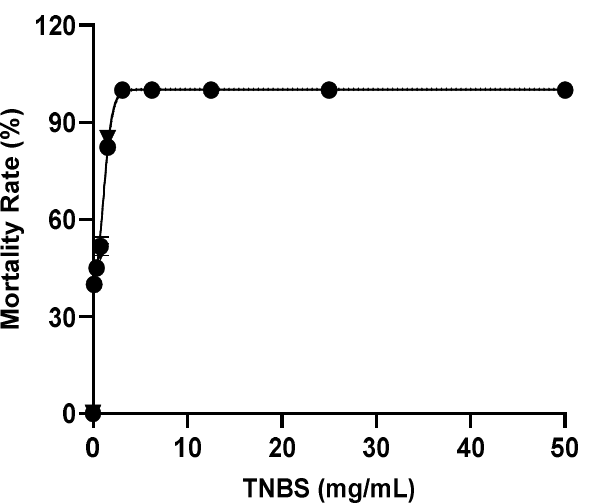
Figure 6. Effect of TNBS at concentrations of 0.2–50 mg/mL on zebrafish larvae (12 dpf) mortality rate. The LC 50 value of TNBS was 0.60 mg/mL.